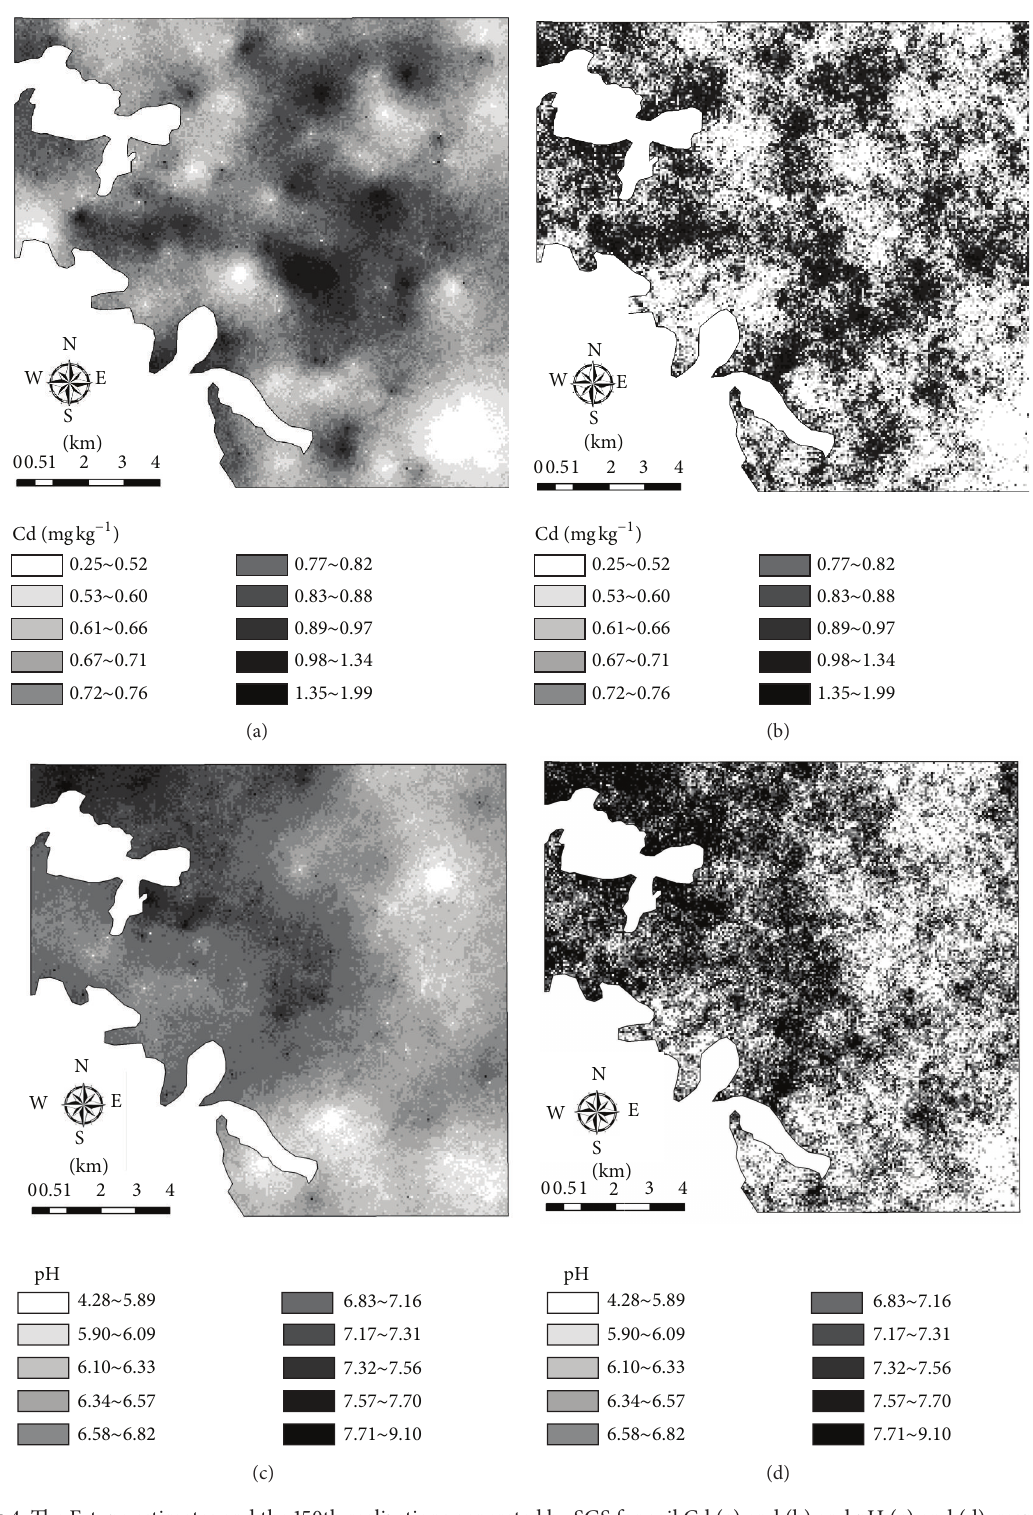
Figure 4: The E-type estimates and the 150th realizations generated by SGS for soil Cd (a) and (b) and pH (c) and (d),